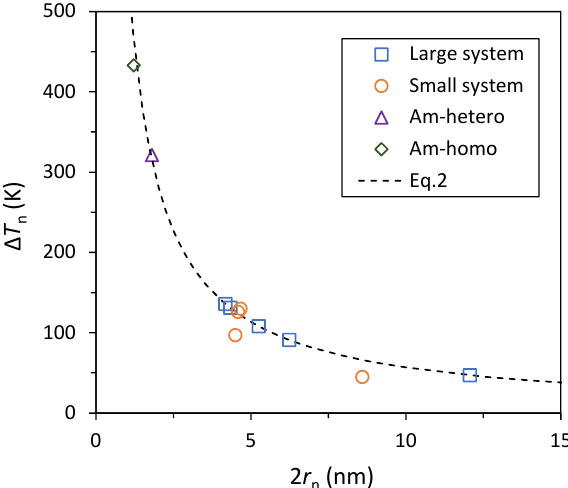
Figure 8. The 2D nucleus size (2 r n ) obtained in different simulation systems plotted as a function of nucleation undercooling ( Δ T n ) in comparison with 2 r * predicted by the classical nucleation theory (Equation (2), the dashed line). The small systems have 5400 atoms; the large systems have about 80,000 atoms; “Am-Hetero” denotes heterogeneous nucleation on a 2D amorphous substrate; and Am-homo” denotes homogeneous nucleation with the presence of a 3D amorphous substrate.